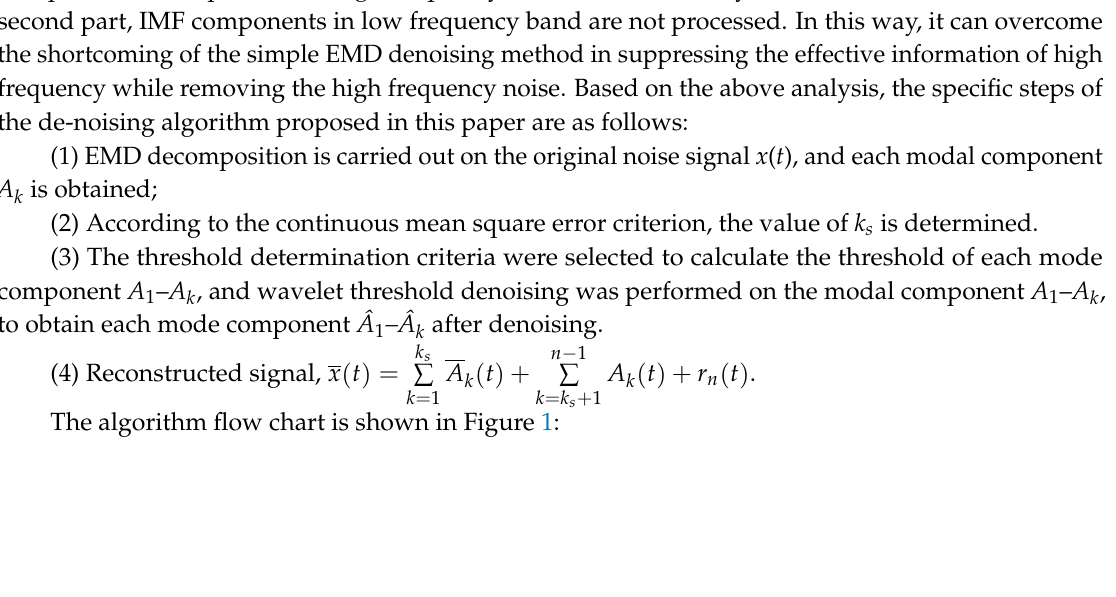
The algorithm flow chart is shown in Figure